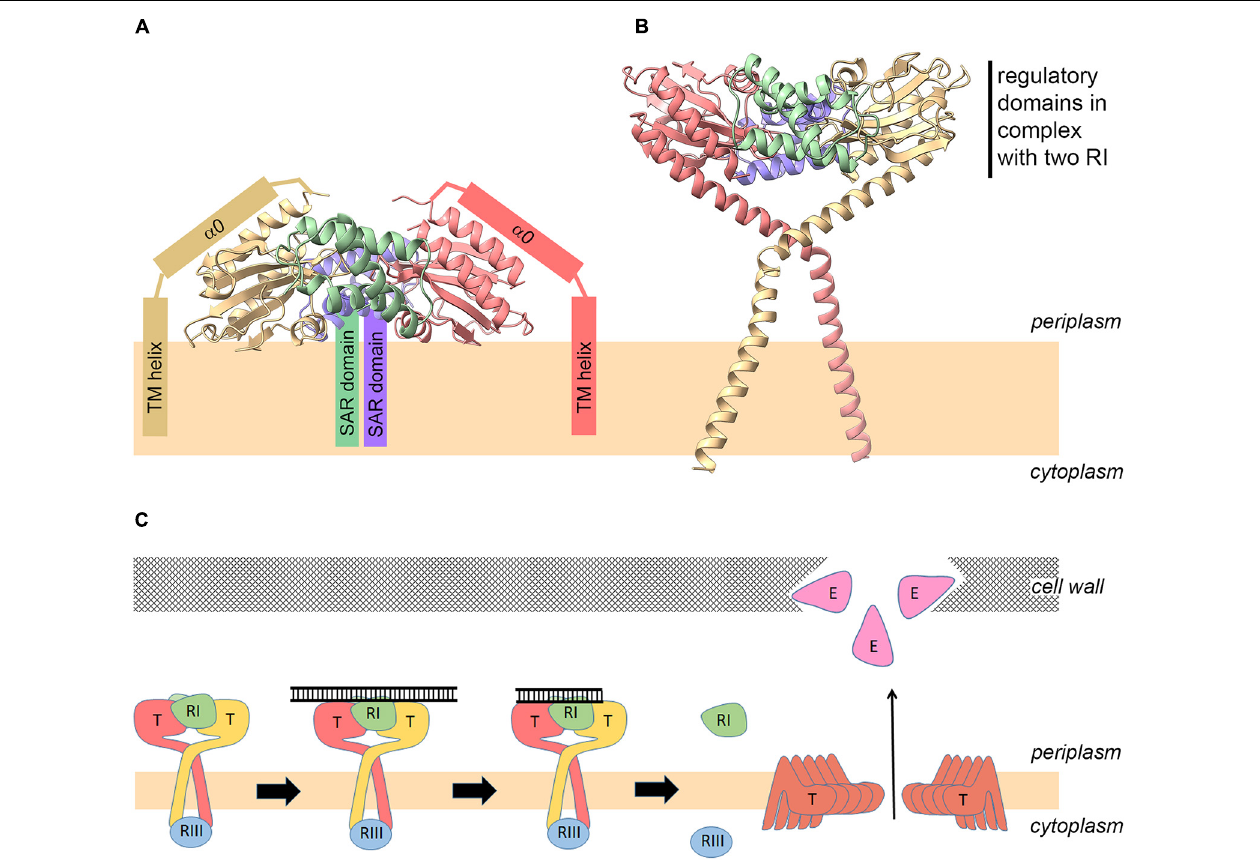
FIGURE 3 | New model for the holin–antiholin complex and revised mechanism of lysis regulation. Model of the holin–antiholin complex as reported previously [ (A) ; Krieger et al., 2020], and as proposed in this study (B) , based on the fact that the antiholin N-termini are not membrane-anchored and therefore do not need to be re-oriented back toward the bilayer. (C) Revised model for regulation of lysis and lysis inhibition (LIN). (1) Early after infection, the lowly abundant holins form complexes with antiholins. (2) On the periplasmic side, the complex between RI and the regulatory domain of the holin can bind periplasmic DNA of superinfections, which inhibits hole formation even at later higher holin abundance due to stabilization of the RI–T interaction. (3) DNA is degraded over time, and (4) when DNA is not sufficiently stabilizing the RI–T complex anymore at later time points, the highly abundant holins can undergo conformational rearrangements that lead to hole formation, resulting in endolysin release and